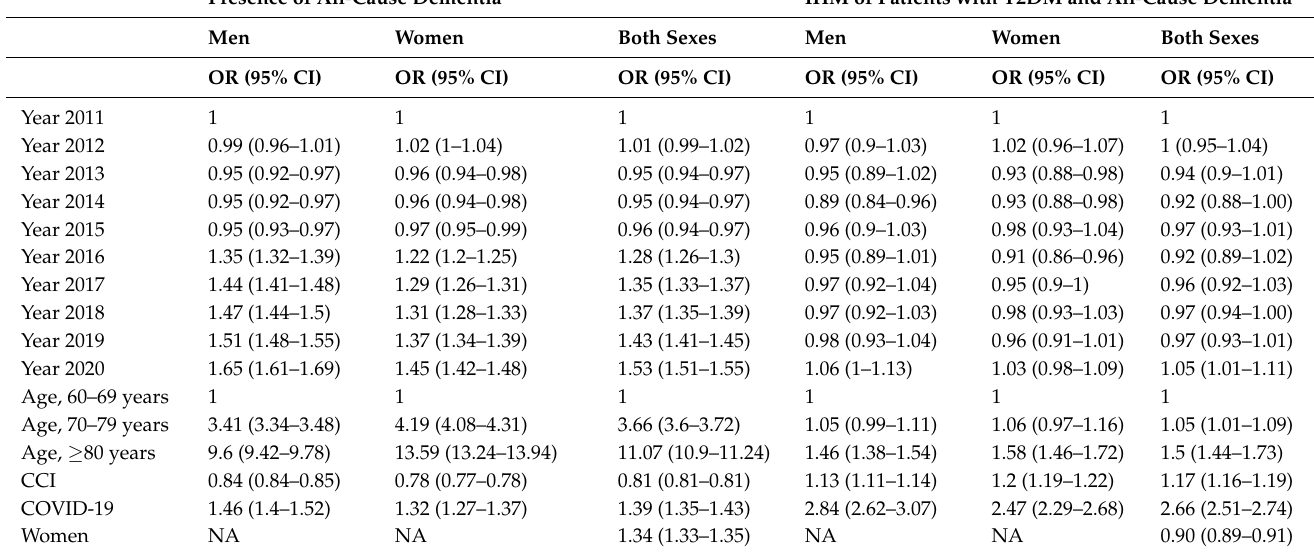
Table 5. Multivariable analysis of the factors associated with the presence of all-cause dementia among men and women hospitalized with type 2 diabetes and factors associated with in-hospital mor- tality among patients with type 2 diabetes and concomitant all-cause dementia in Spain, 2011–2020. Presence of All-Cause Dementia IHM of Patients with T2DM and All-Cause